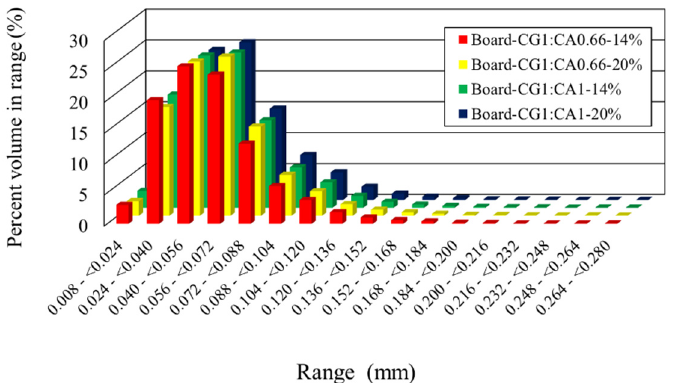
Figure 9. Pore size distribution of the wood fiber insulation boards.